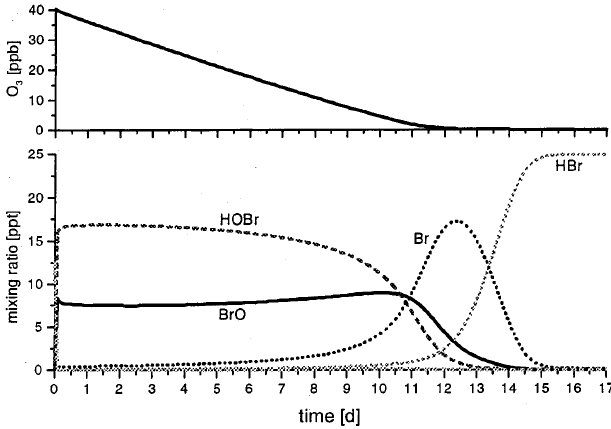
Fig. 13. Model calculation: analogous to Fig. 12, time-dependent development of O 3 and bromine compounds including heterogeneous oxidation but for only half of the initial bromine compared to